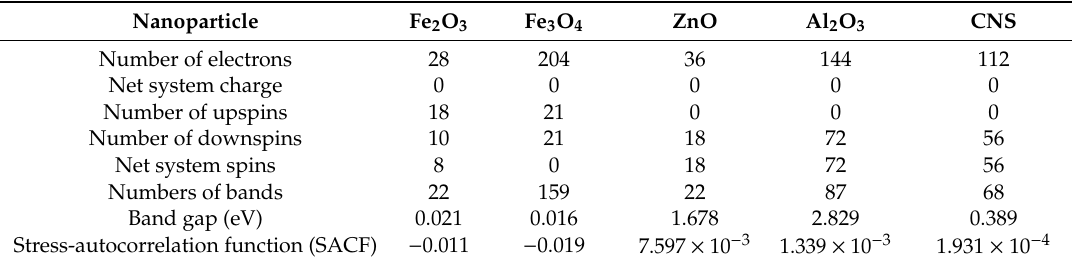
Table 1. Electronic nanomaterial